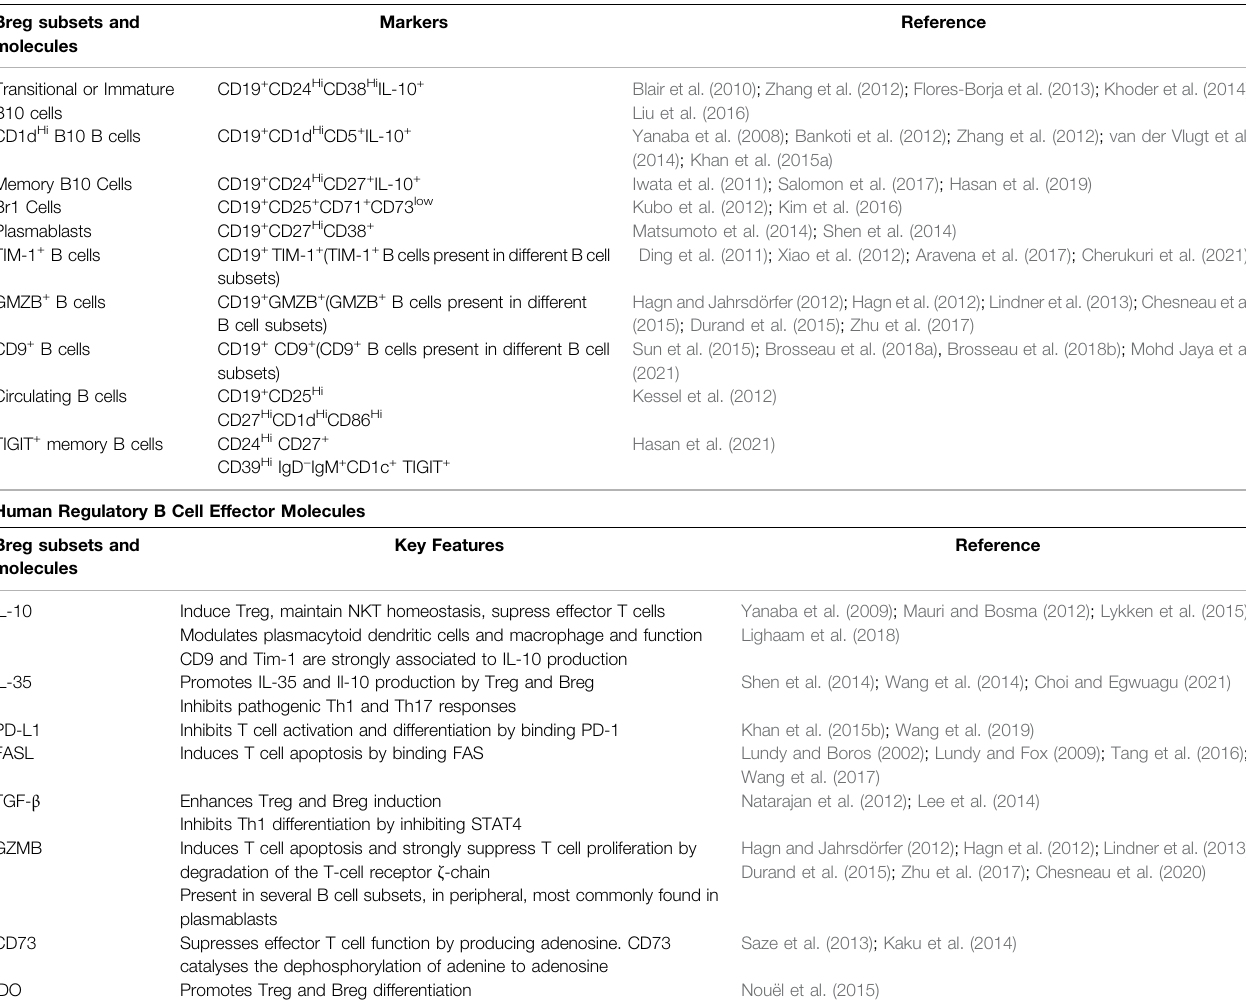
TABLE 1 | Breg Human Cellular markers and Effector molecules. Human regulatory B cell markers Breg subsets and